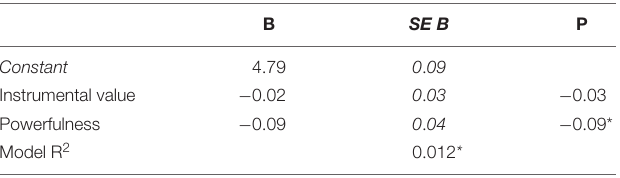
TABLE 8 | Regression analysis – self-objectification as dependent variable ( N =